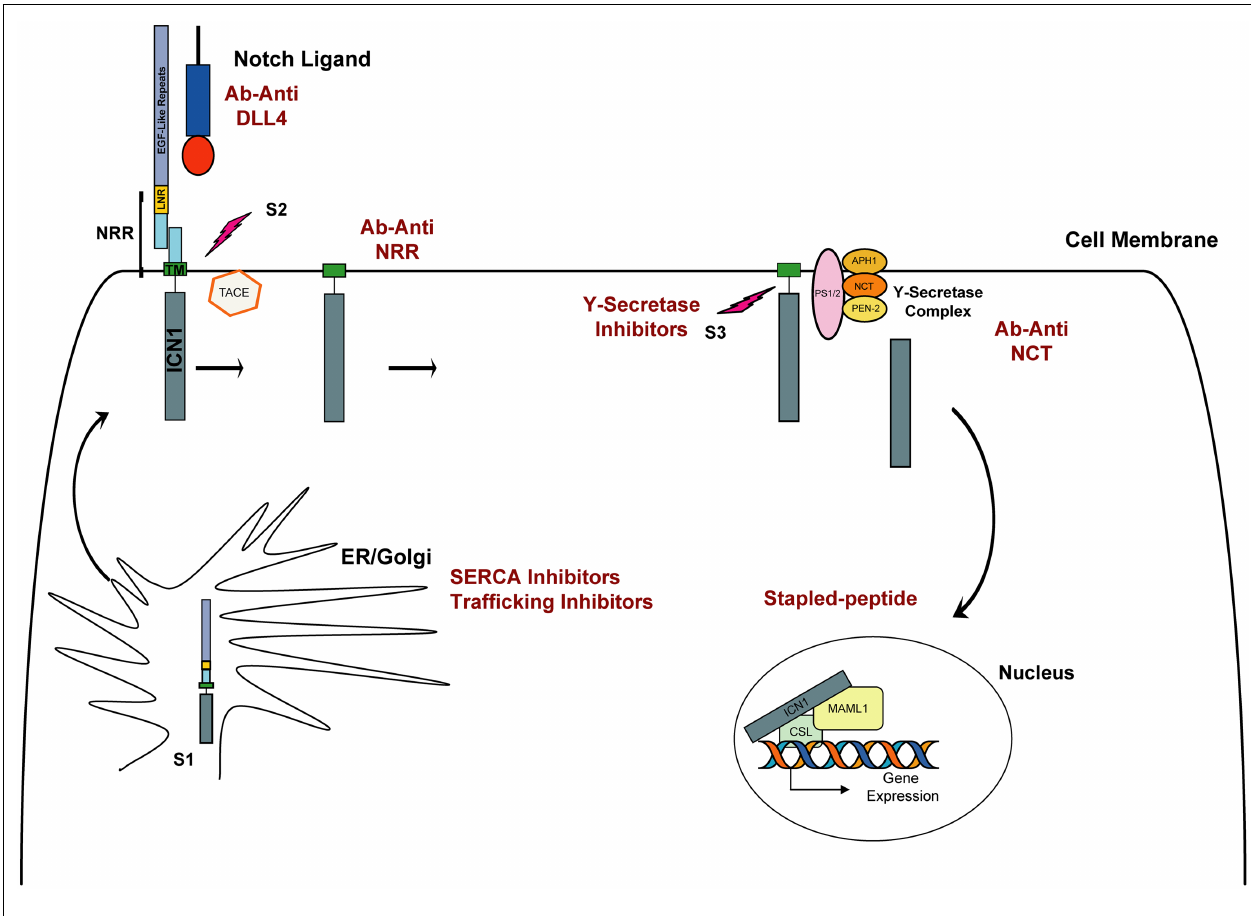
transmembrane domain and is mediated by the activity of γ -secretase, a complex composed of four proteins: presenilin (PS1/2), nicastrin (NCT), APH-1, and PEN-2. Intracellular NOTCH1 (ICN1) is released and translocates to the nucleus. In the nucleus, ICN1 binds to the CSL transcription factor, converting it from a transcriptional repressor into a transcriptional activator while recruiting the coactivator MALM1. In red are indicated approaches to inhibit Notch